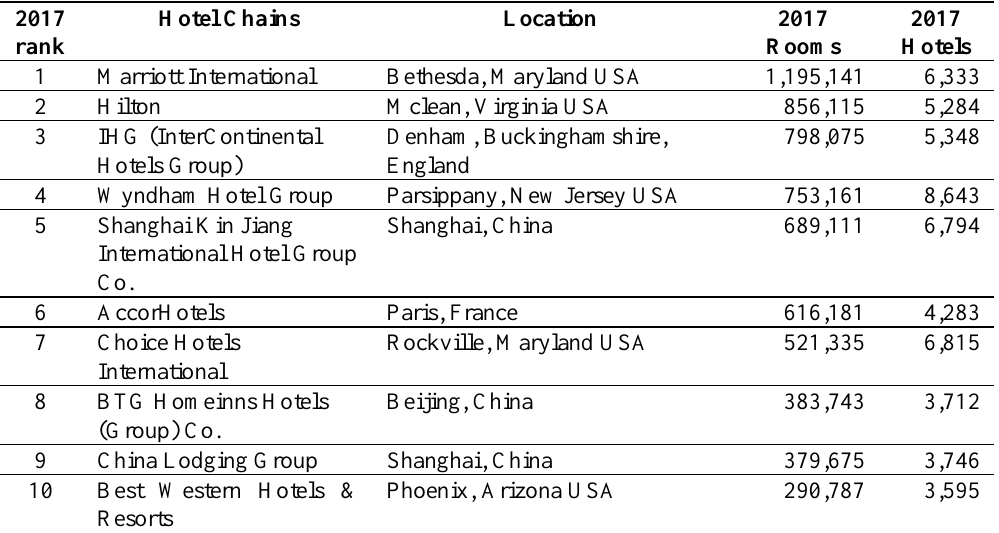
Table 2: The Companies Analysed